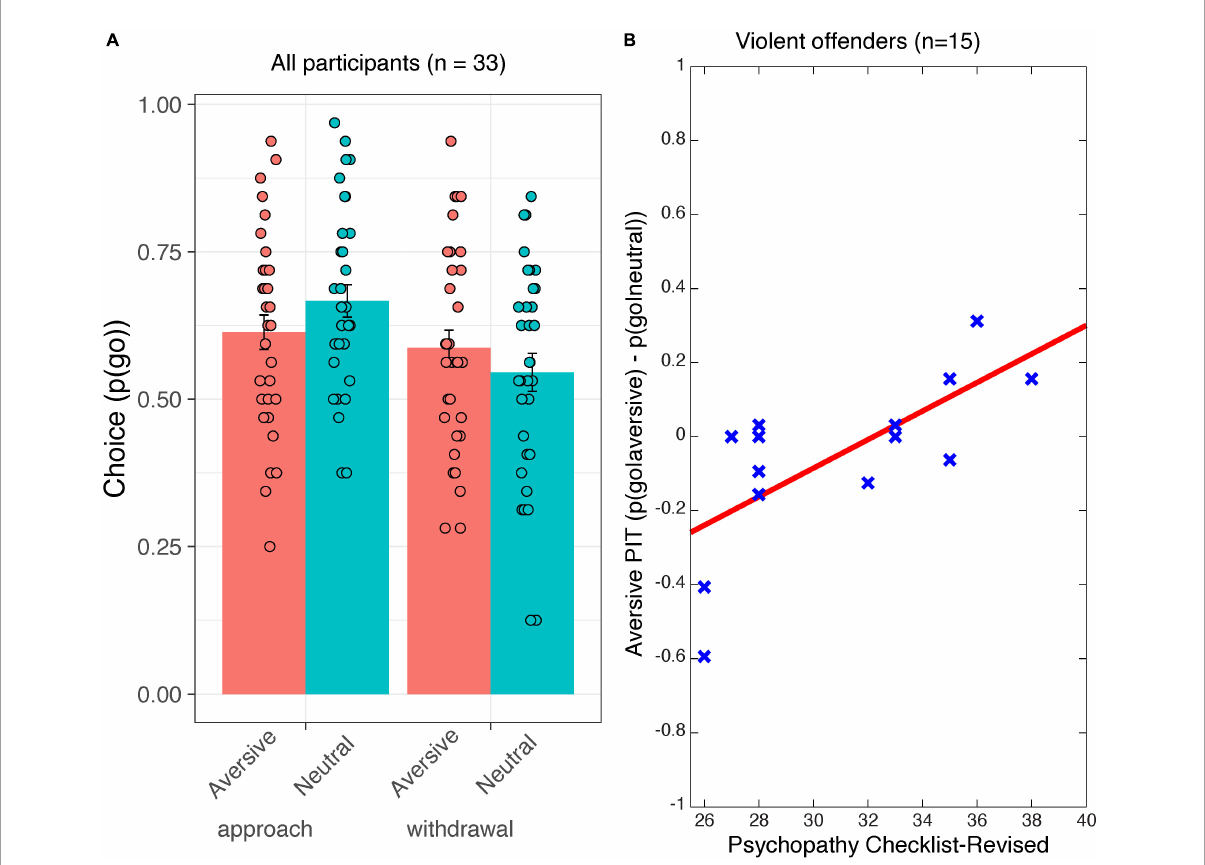
FIGURE2 Behavioral data from the Pavlovian-instrumental transfer stage. Shown are (A) choice [ p (go)] as a function of Action Context (approach and withdrawal) and Valence (aversive/neutral) for all participants. Error bars represent standard errors of the mean. (B) The correlation between aversive PIT [i.e., p (go| aversive)– p (go| neutral)] and psychopathy severity (in terms of the psychopathy checklist–revised total score). The red line is the ordinary least square trend line. Each cross represents an individual data